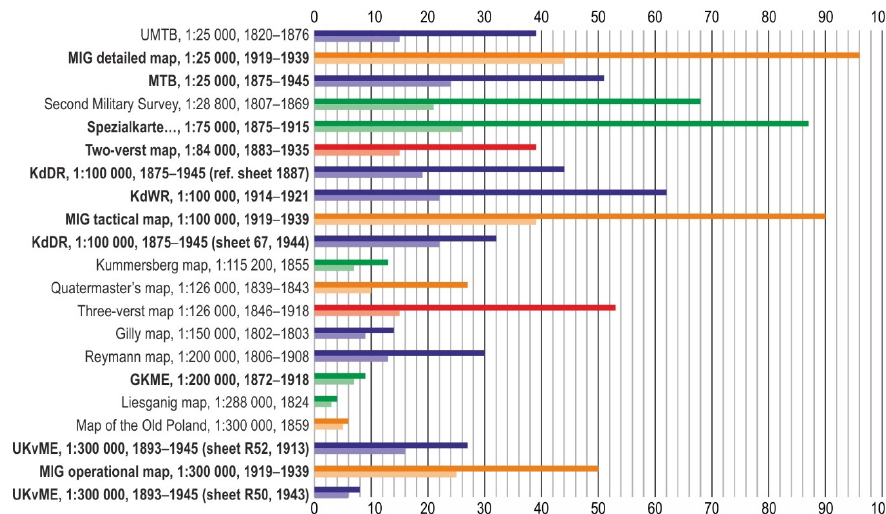
Fig. 5. Number of feature types on different maps’ key to symbols among “buildings, structures and installations” feature class category (before and after